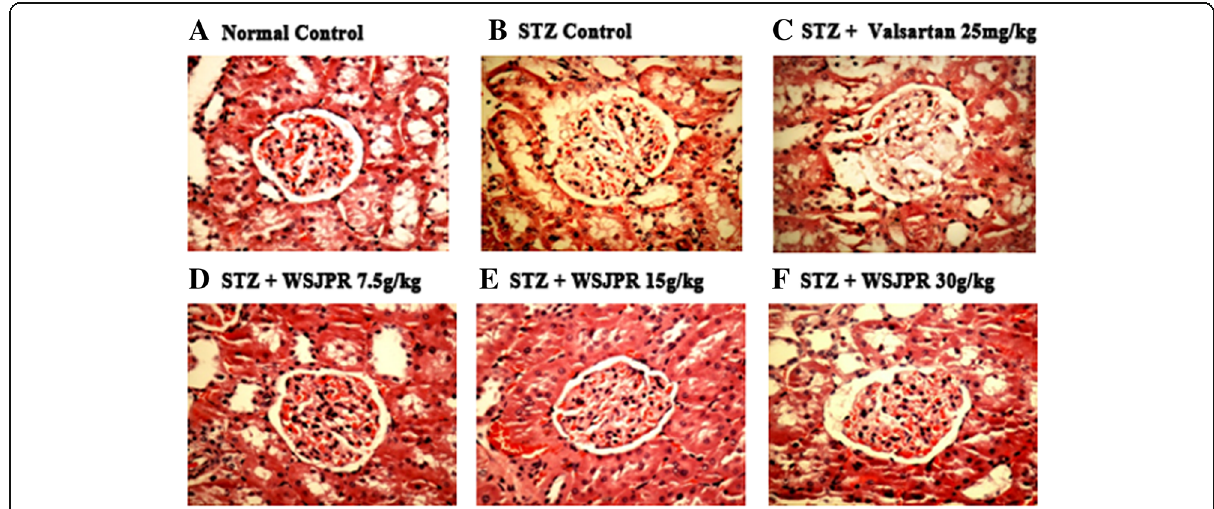
Fig. 5 Effect of WSJPR on the renal histomorphology in rats (HE staining, 400× magnification). a Normal control; b STZ control; c STZ + valsartan 25 mg/kg; d STZ + WSJPR 7.5 g/kg; e STZ + WSJPR 15 g/kg; f STZ + WSJPR 30